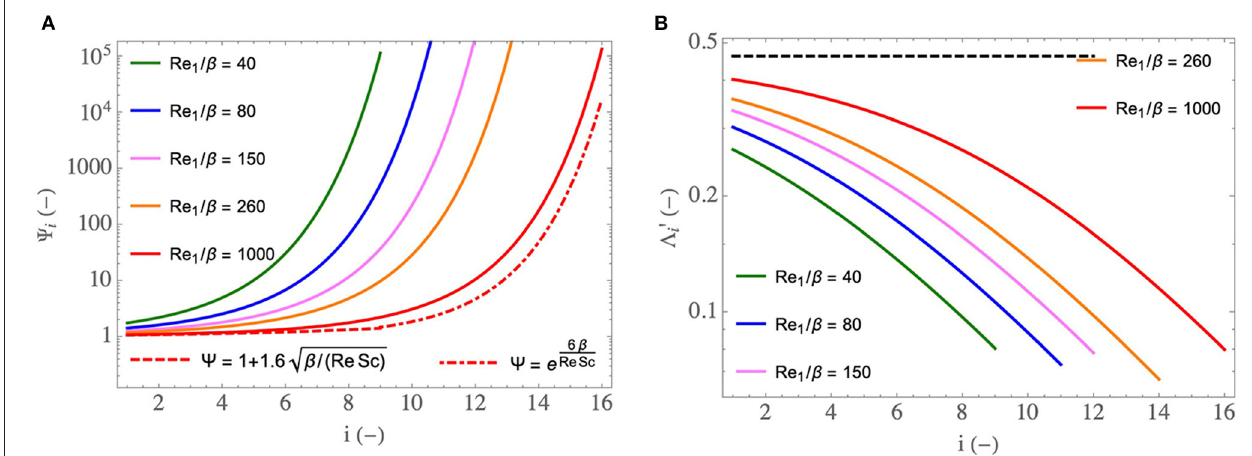
FIGURE 6 | (A) 9 insp i as a function of i , for different Re insp 1 /β . (B) 3 ′ i as a function of i , for different Re insp 1 /β and for φ/ψ Re insp 1 /β and φ/ψ 1 (i.e., it is the value of 2 ). Re insp 1 /β 40 corresponds to a newborn at rest ( M → ∞ = = Re insp 1 /β 150 to a small adult at rest ( M 50 kg), Re insp 1 /β 260 to a large adult at rest ( M = = =